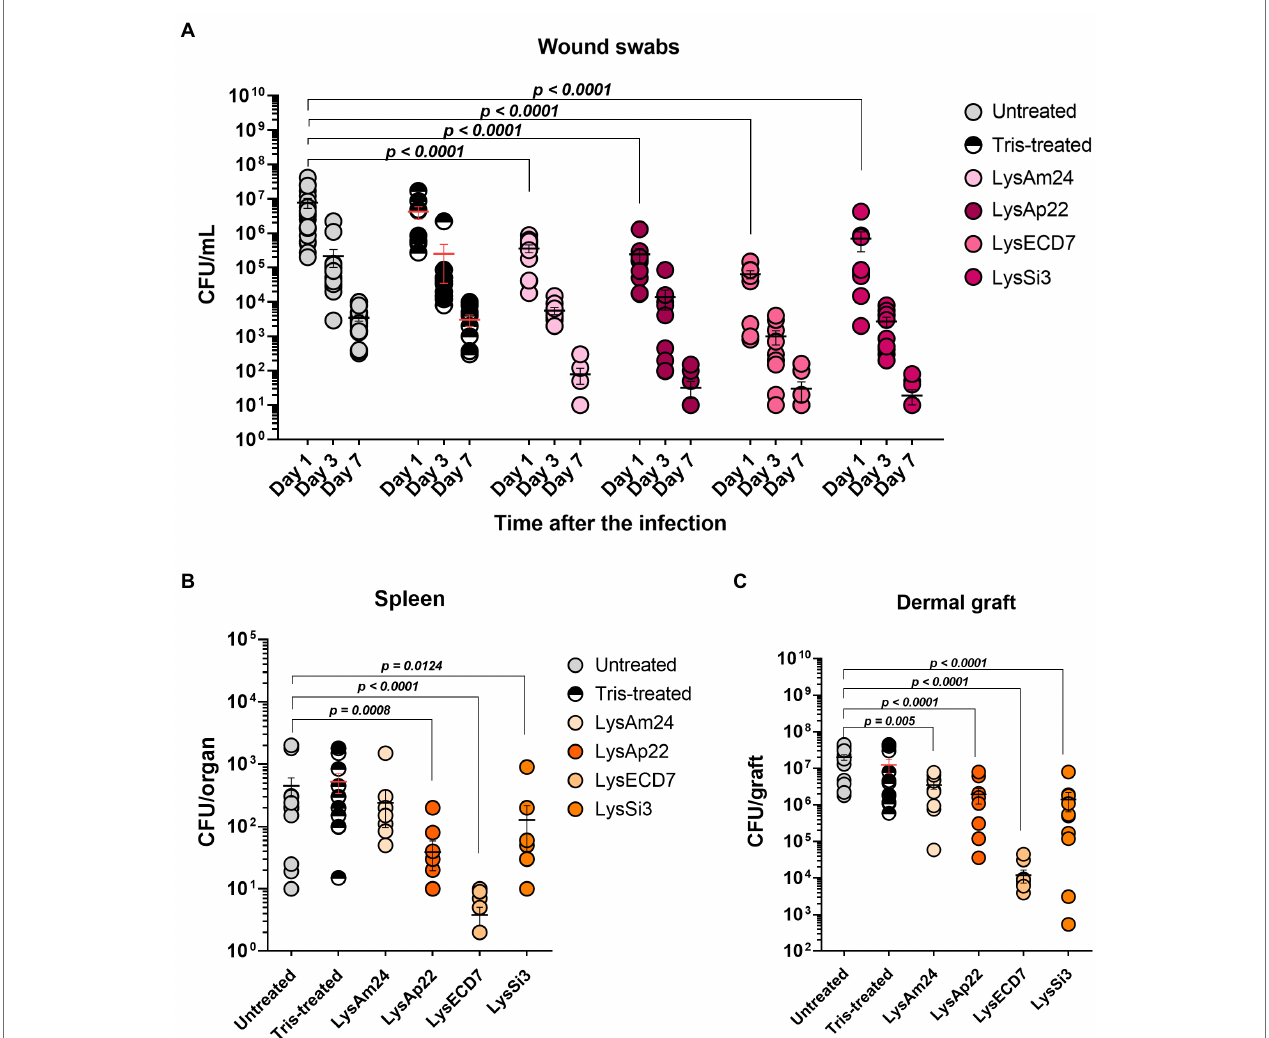
FIGURE 6 | Burn wound model of Wistar rats infected with the P. aeruginosa Ts 38-16 strain and epicutaneously treated with control buffer or 2,500- μ g/ml endolysin solutions. (A) Count of culturable bacteria in the wound swabs of the infected areas. Significant differences are shown as p values; otherwise, no statistical difference was found (two-way ANOVA with the Sidak multiple-comparison test). Spleen (B) and dermal graft (C) microbial contamination (CFU/organ) on the seventh day of the experiment are shown. Significant differences are shown as p values; otherwise, no statistical difference was found (Mann–Whitney test). The resulting CFU/mL, CFU/graft, or CFU/organ values from each animal are plotted as individual points. Data are shown as mean ±